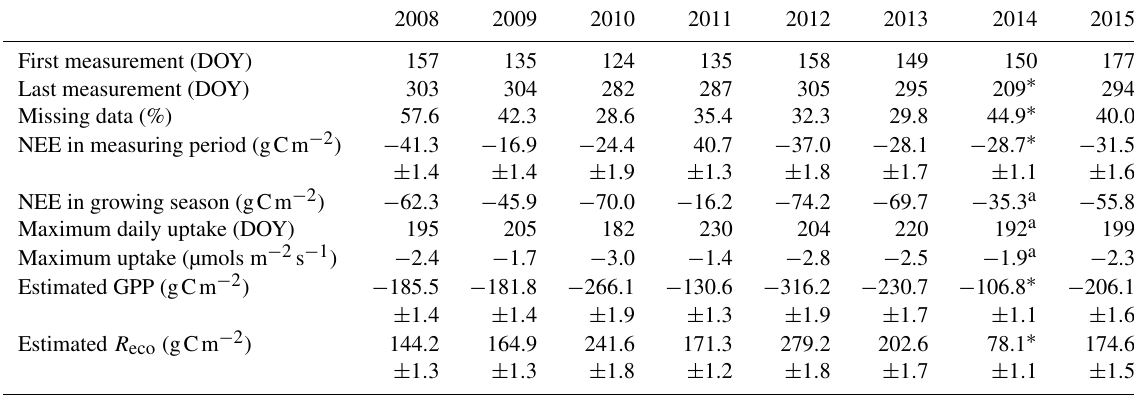
Table 2. Summary of the measuring periods and the growing season CO 2 fluxes for the period 2008–2015.